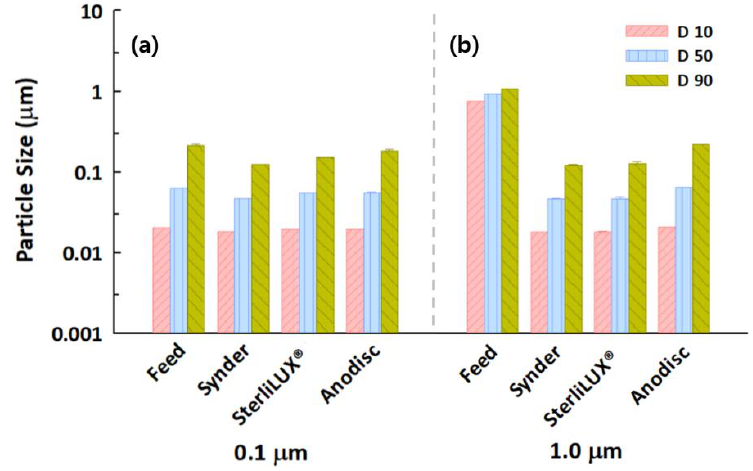
Figure 5. Particle size distributions in feed and permeate water samples after membrane filtration for (a) 0.1 μm and (b) 1.0 μm PS microplastics with the same concentration. ( a ) 0.1 µ m and ( b ) 1.0 µ m PS microplastics with the same